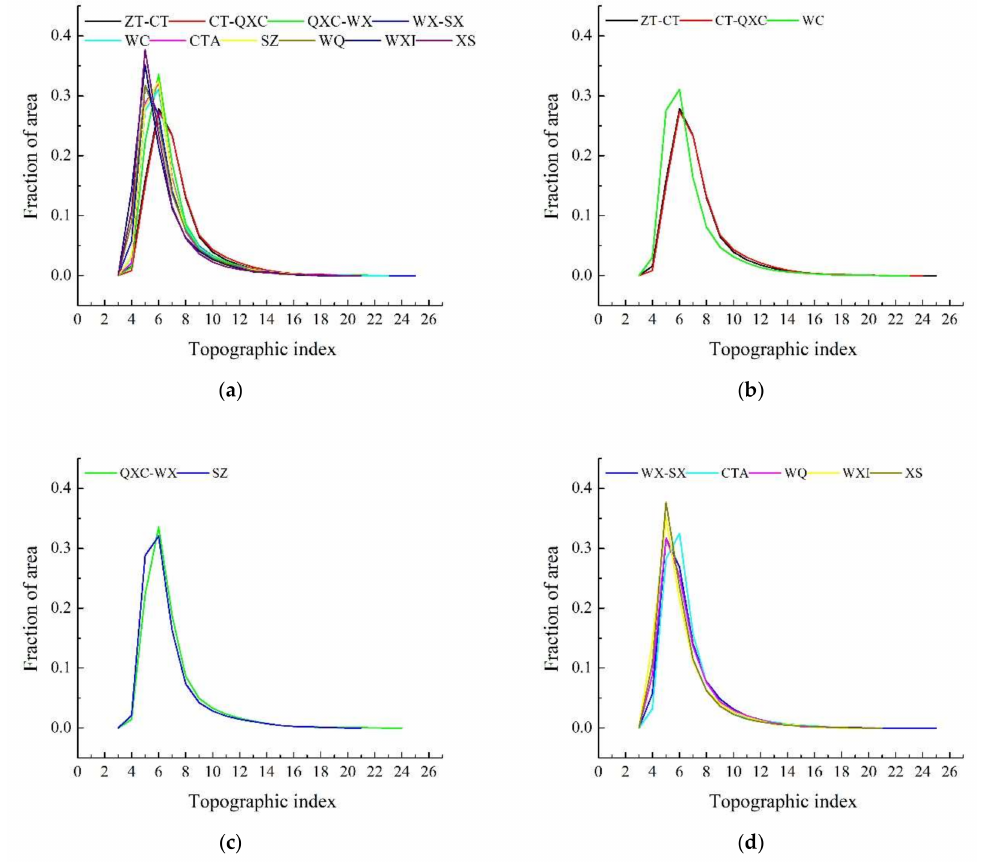
Figure 6. Topographic index probability density distribution curve for six sub-basins in di ff erent groups. The topographic index probability density distribution curves of the 10 regions ( a ), the first group ( b ), the second group ( c ), the third group ( d